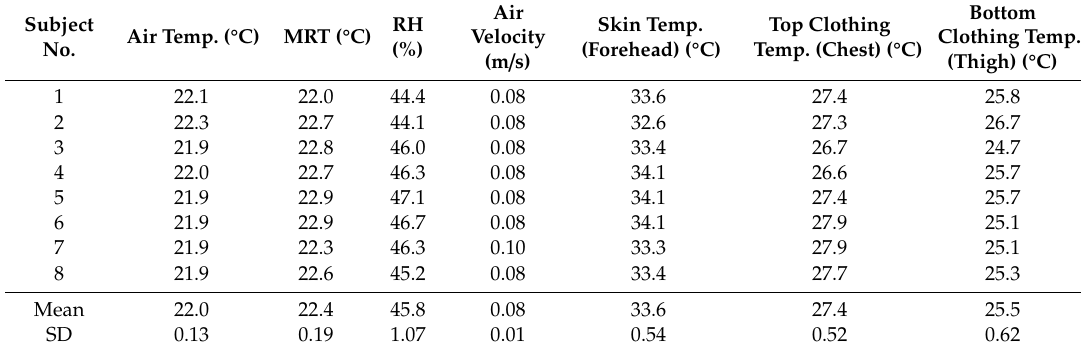
Table 3. Results of winter season experiments (mean ± standard deviation).